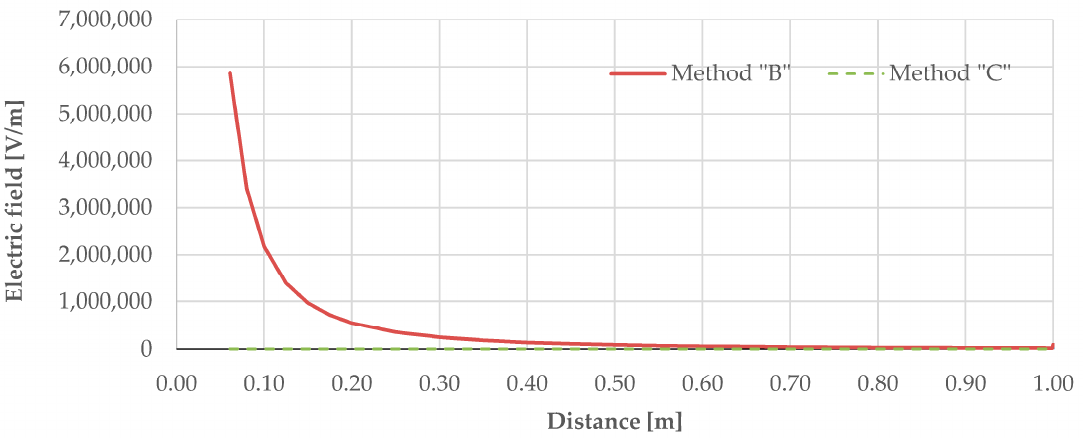
Figure 14. Electric field strength diagram, with respect to distance within the breakwater ( r < 1.0 m), with three methods, “A”, “B” and “C”, for the case of Stachtoroi ( θ w = 0.2718 ◦ , θ = 210 ◦ , r 1 = 1.0 m, r 2 = 17.0 m, r 3 = 10.0 m, r ∞ = 150 km, ρ s = 1,000 Ω · m, ρ d = 100 Ω · m).